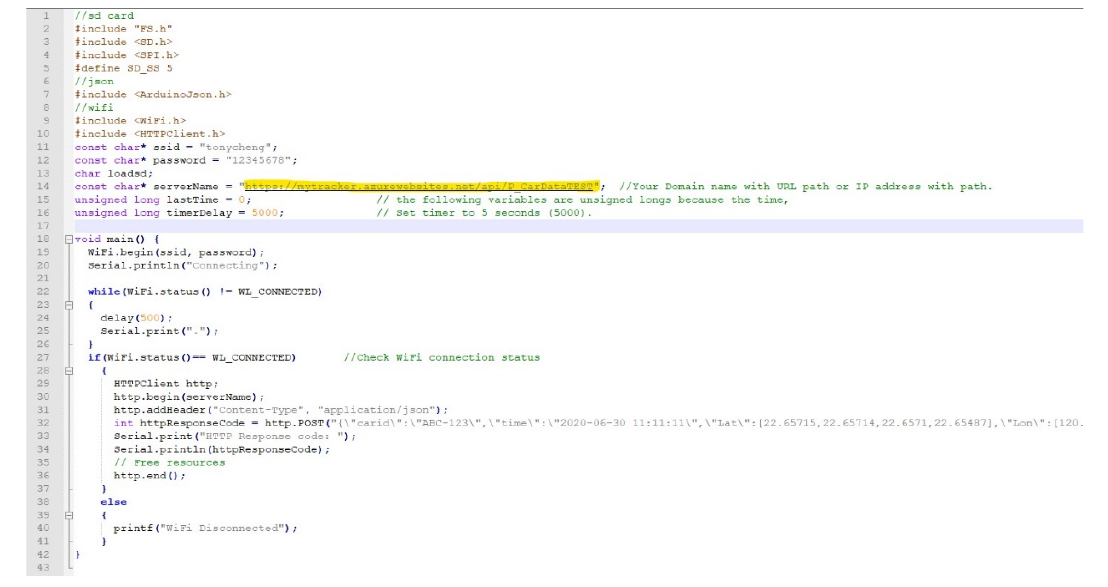
Figure 26. Third-party software Postman transmission test1.